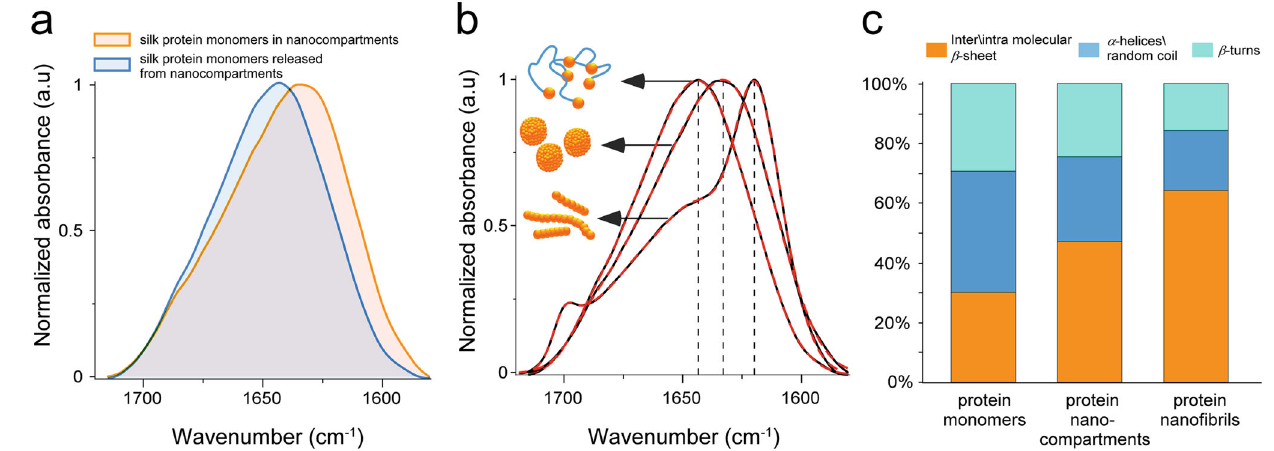
Fig. 2 | Bulk Fourier Transform Infrared spectroscopy (FTIR) analysis of supramolecularsilk fi broinassemblystates.a AmideIregionIR-spectrashowing overlap of monomers released from nanocompartments (blue) and monomers withinthe nanocompartments(orange).The analysiscon fi rmsthe re-folding event in protein monomers upon nanospherical assembly disintegration. b Amide I